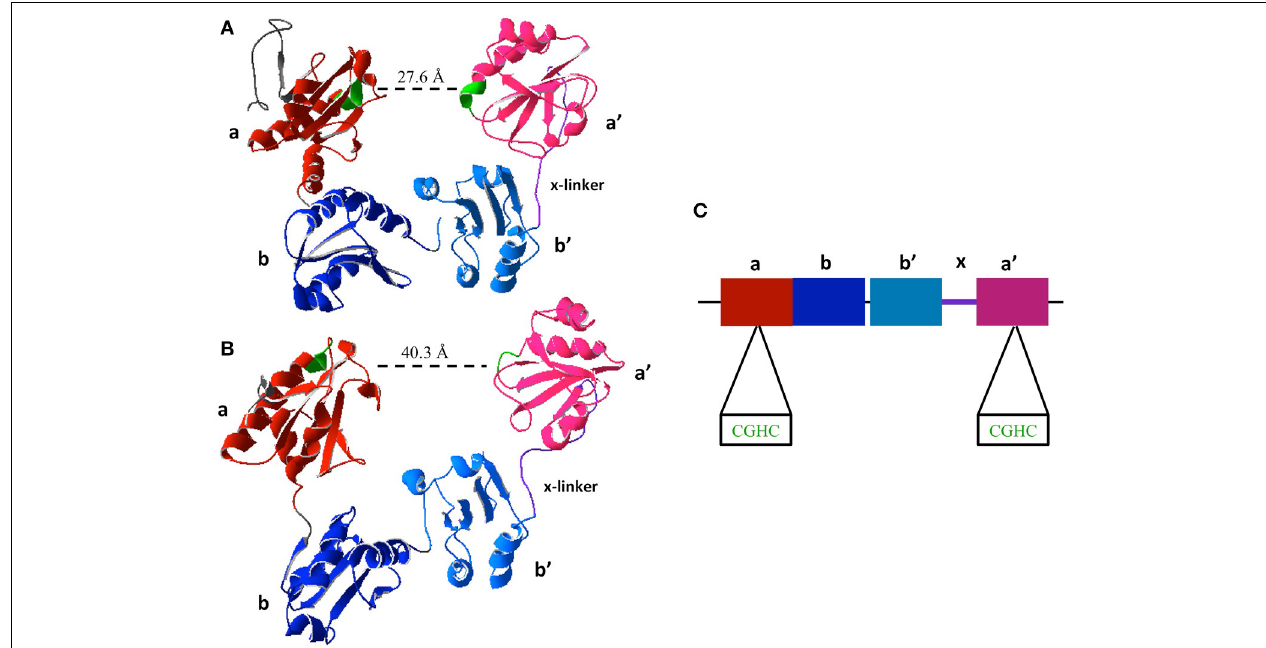
FIGURE 2 | Crystal Structure of Reduced and Oxidized PDI. (A) Reduced crystal structure of human PDI (PDB ID: 4EKZ). (B) Oxidized crystal structure of human PDI (PDB ID: 4EL1). (C) Schematic of PDI